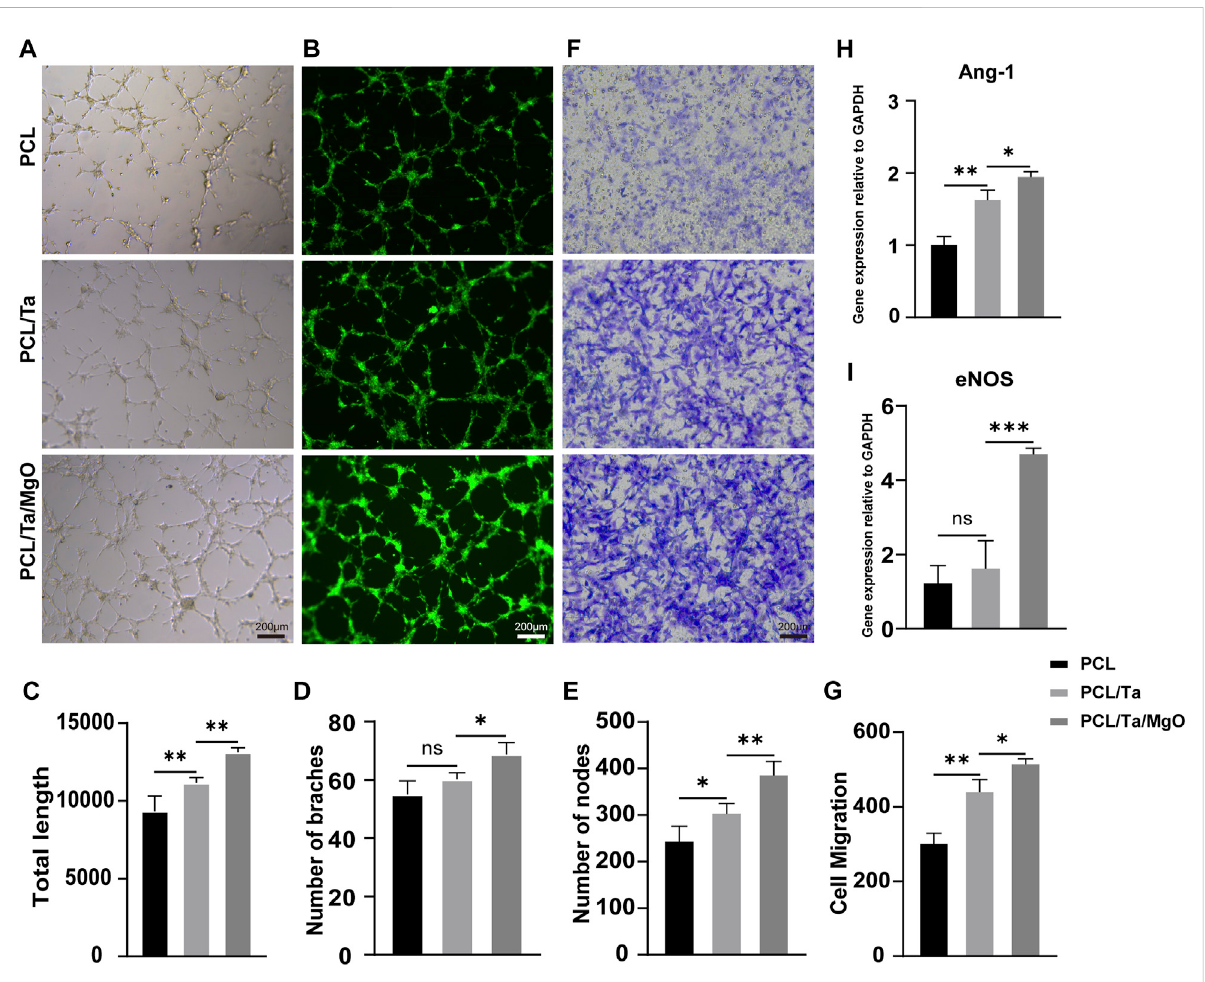
FIGURE 5 Evaluation of the in vitro angiogenic ability of EPCs on different membranes. (A) Representative bright- fi eld images, (B) fl uorescence images stainedwith Calcein-AM,and (C – E) quantitative analysis ofthetube formation assayat4 h. (F) Representative imagesand (G) quantitative analysis of the Transwell assay on day 1. Expression levels of angiogenesis-related (H) Ang-1 and (I) eNOS genes in EPCs on day 1 ( n = 3). (* p < 0.05, ** p < 0.01, *** p < 0.001, and **** p <